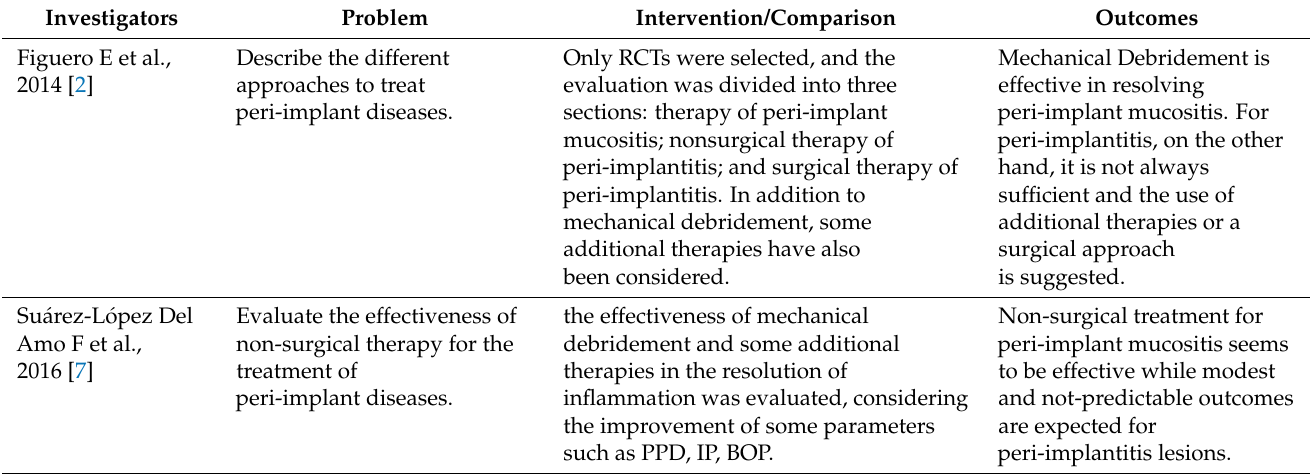
Table 6. Summary of Systematic Review and